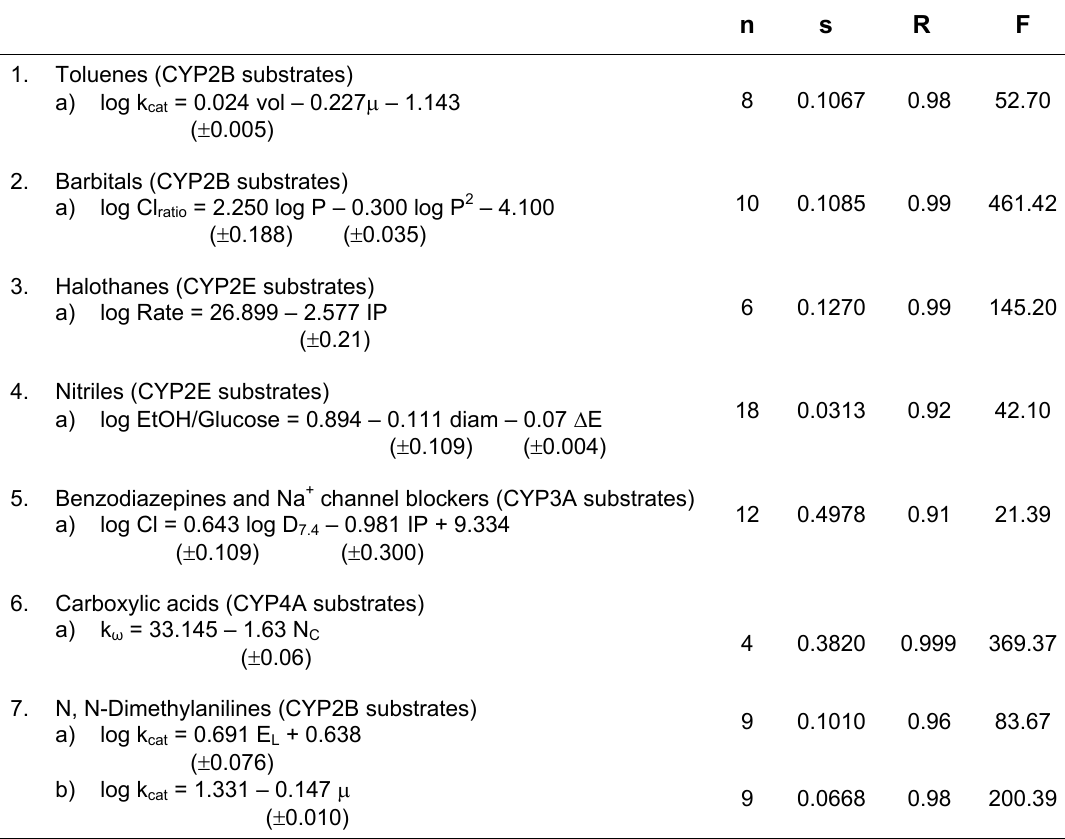
QSARs for Rates of P450-Mediated